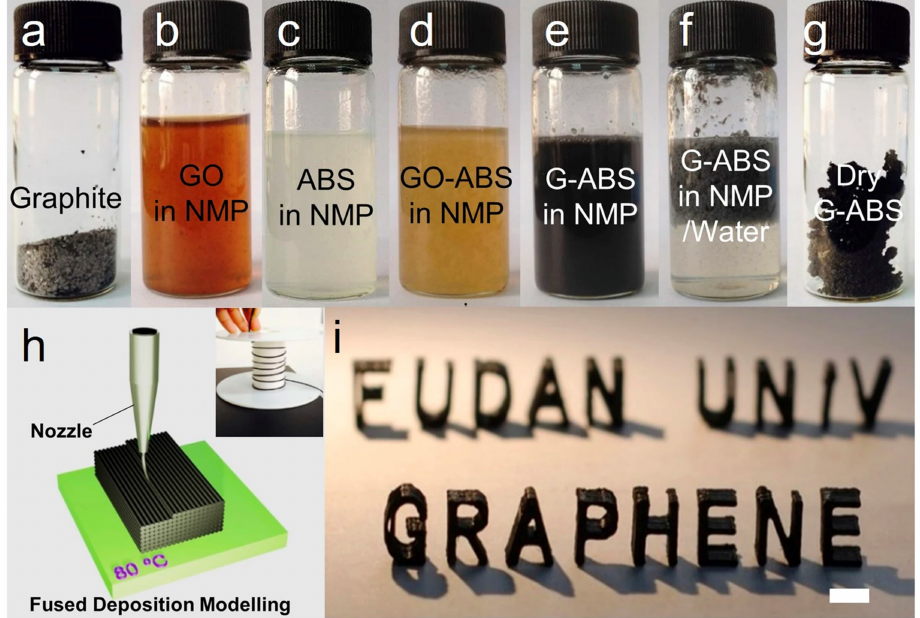
Figure 13. Photograph of ( a ) graphite flakes; ( b , c ) dispersions of graphene oxide(GO) and ABS in N-methylpyrolidone (NMP) solvent; ( d , e ) a homogeneous mixture of GO-ABS in NMP before and after chemical reduction; ( f ) graphene(G)-ABS clots found after isolation ( e ) with water; ( g ) G-ABS composite powder after washing and drying; ( h ) schematic illustration of fused deposition modeling 3DP, the inset shows the graphene-based filament winding on a roller; ( i ) a typical 3D printed model consuming 3.8 wt% G-ABS composite filament, scale bar: 1 cm. Reprinted with permission from reference [104], Copyright 2015,